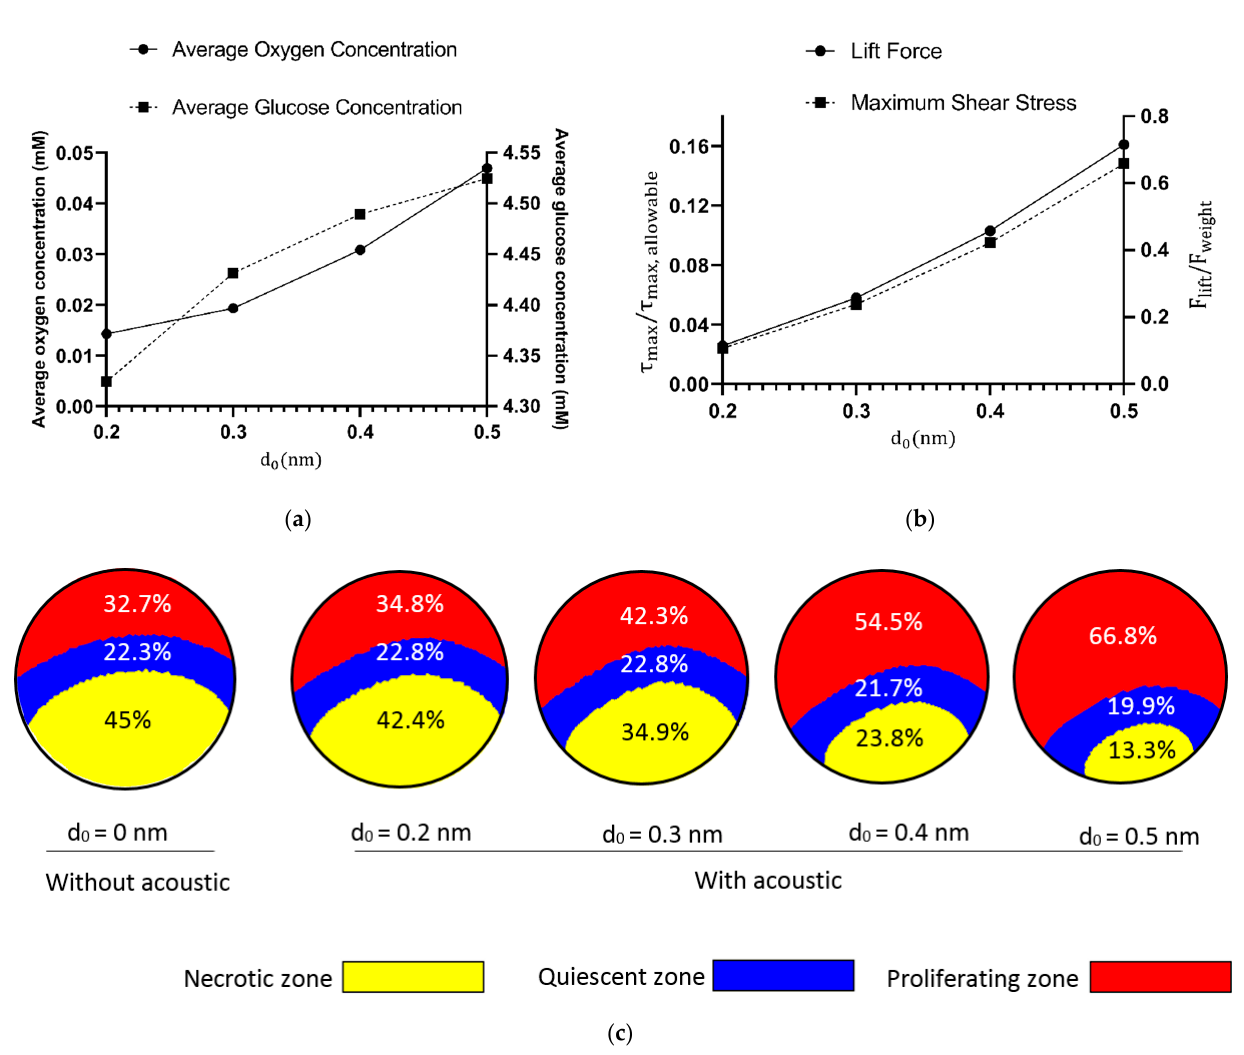
Figure 7. ( a ) Effect of d 0 on glucose and oxygen concentrations inside the spheroid. With an increase in the magnitude of d 0 , more oxygen and glucose will be found inside the cell aggregate, and the better cells in the inner side and the core will be nourished. ( b ) While increasing d 0 is beneficial due to enhancement of oxygen and glucose concentrations, it is not also causing any side effects such as high magnitudes of fluid shear stresses or lift forces. Here, τ max represents the maximum value of shear stress which is exerted to the peripheral boundary of the spheroid. ( c ) Graphical illustration of oxygen’s proliferation zone after applying the acoustic field. Before applying acoustic to the microchip, the proliferation zone had only a 32.7% share of the spheroid. With the acoustic field, this share is increased to 66.8%.